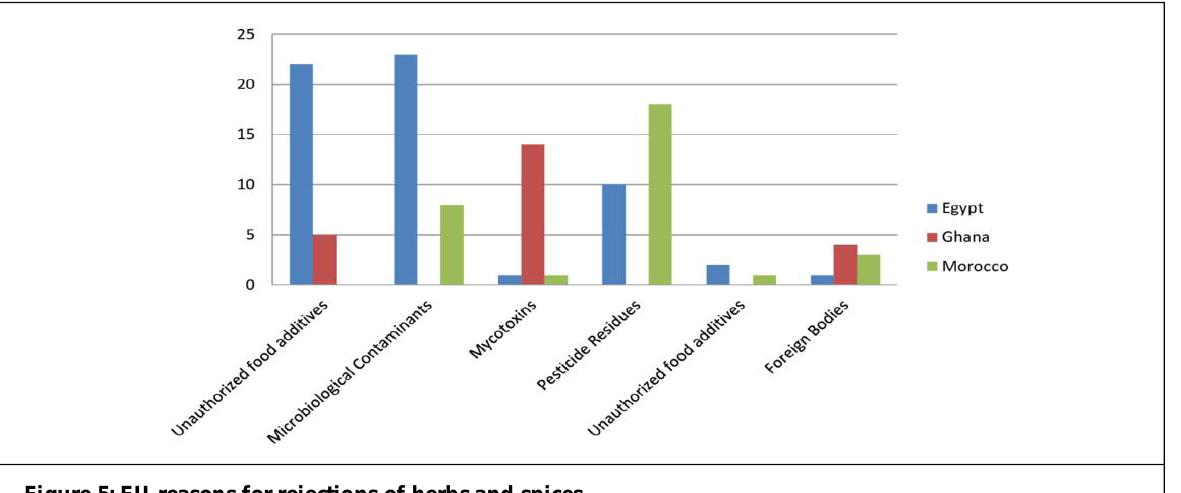
Figure 5: EU reasons for rejections of herbs and spices Source: RASFF statistics online Data Base; https://ec.europa.eu/food/sites/food/files/safety/docs/